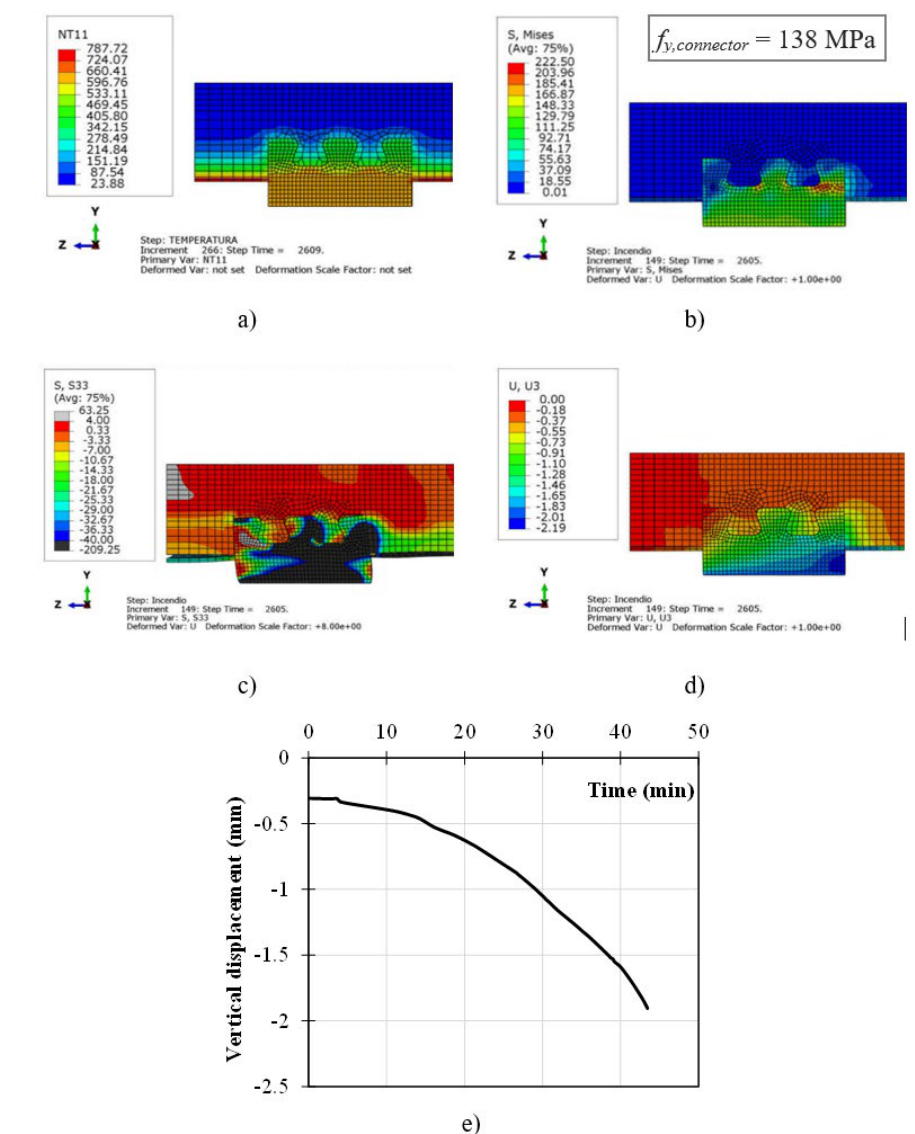
Figure 9. a) Temperature distribution, b) von Mises stresses, c) concrete tensile stresses, d) deformed configuration and e) displacement of the central point of the external surface of the connector of 400 mm diameter CFCCs with Crestbond shear connector for the loading level of